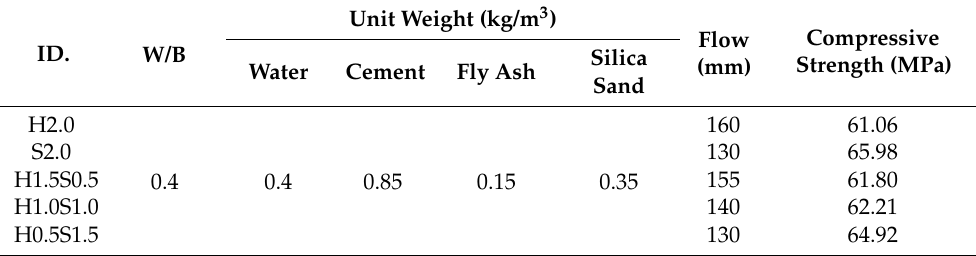
Table 4. Mix proportions and compressive strength of HPFRCC.